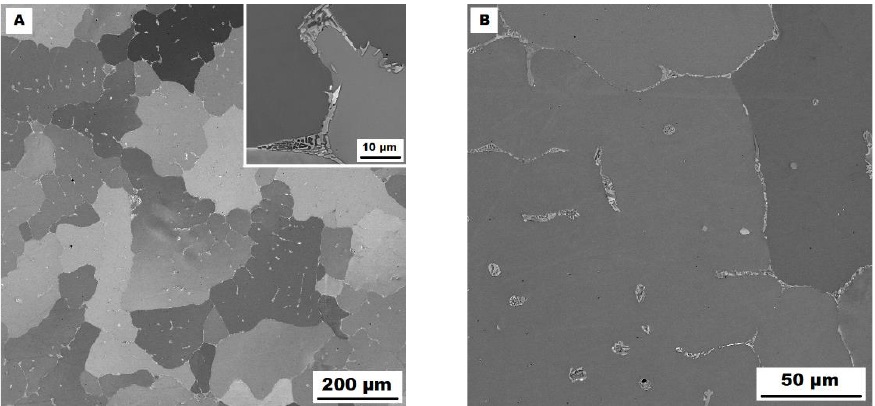
Figure 2. The structure of Fe–28Al–5Si–1B alloy in the as-cast state (SEM, 10 kV, BSE). ( A ) overview of the structure, ( B ) detail of the structure.